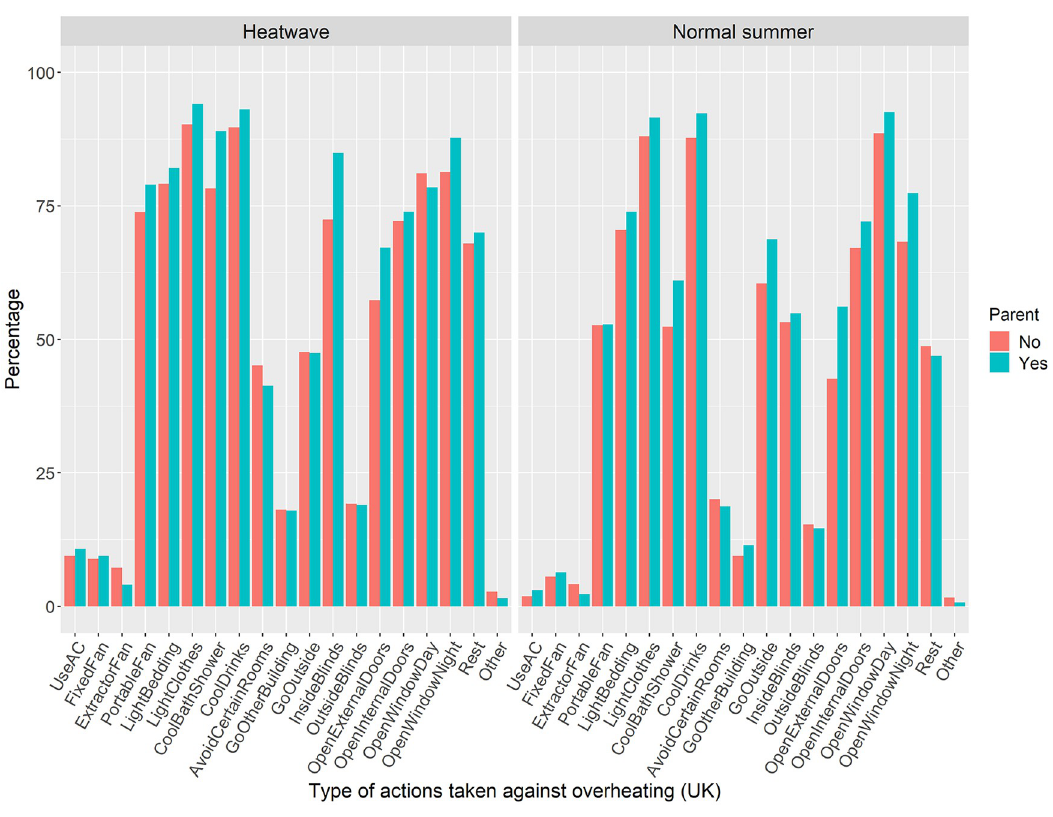
Fig 4. Type of overheating actions taken during a heatwave and a normal summer in the UK, split up by parental